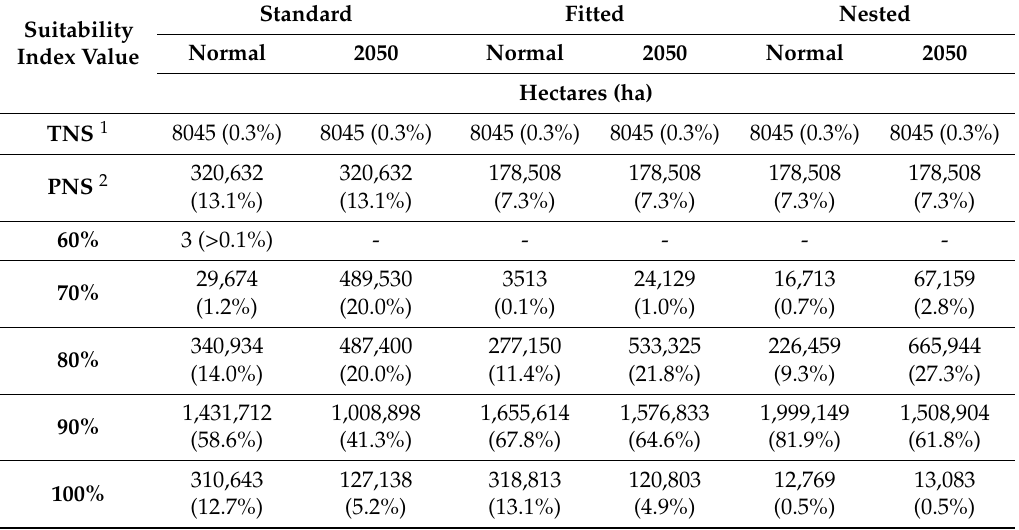
Table 3. Total hectare output for each suitability index value class in the study region for each of the three suitability modelling methods in a climate normal and a 2050